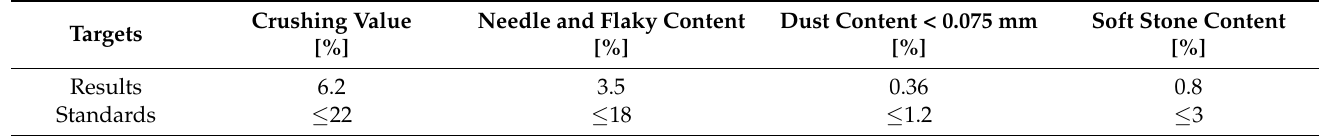
Table 2. Test results of cement performance indices.